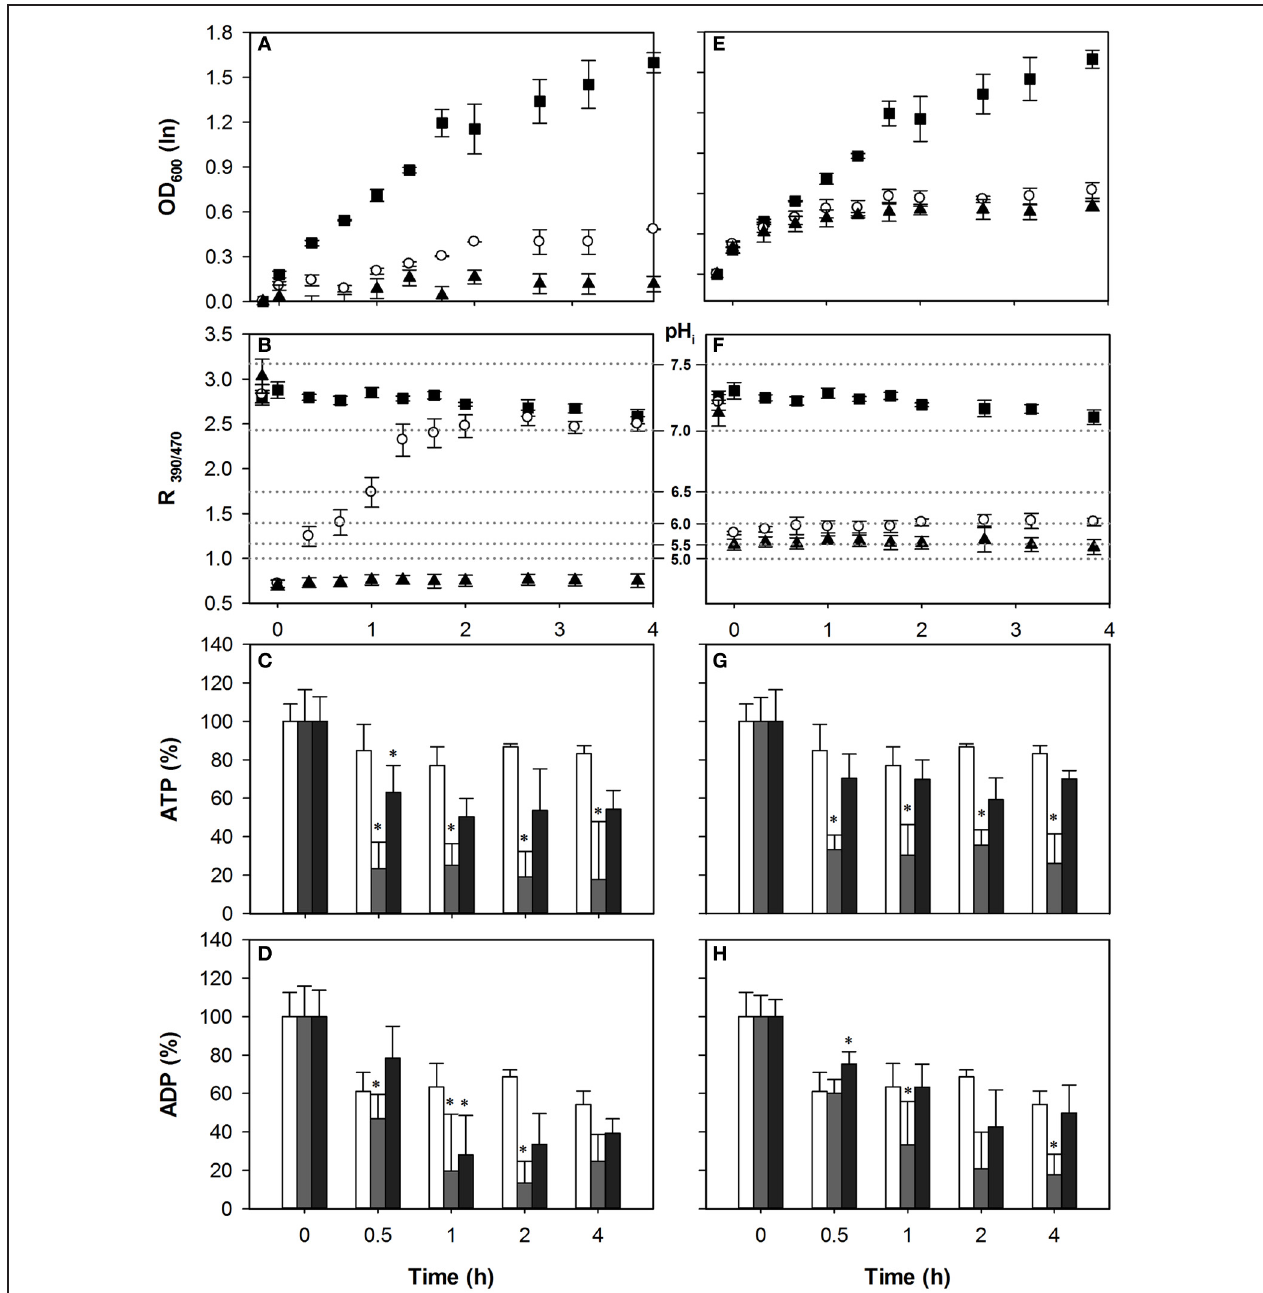
FIGURE 2 | Effect of acetic acid (left hand panels) and sorbic acid (right hand panels) on growth (A,E), intracellular pH (B,F), ATP (C,G), and ADP (D,H) levels of BY4741. Growing cultures were exposed to 0mM ( (cid:2) and white bars), 40mM HA or 1mM HS ( ◦ and gray bars), and 70mM HA or 2mM HS ( (cid:3) and dark gray bars) at t = 0. pH i data are presented as ratio of fluorescence emission upon excitation at